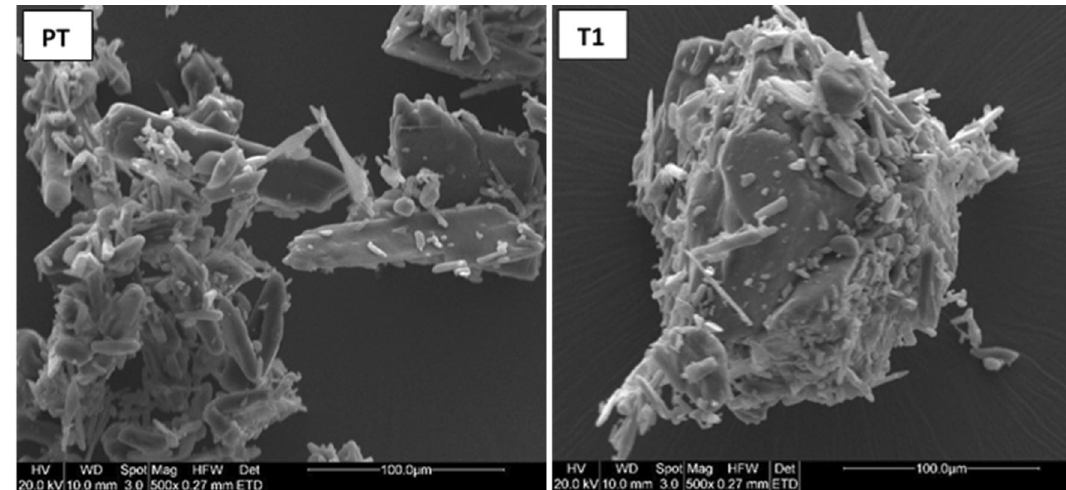
Figure 7. SEM images of raw PCT and T1 as a reference formula.